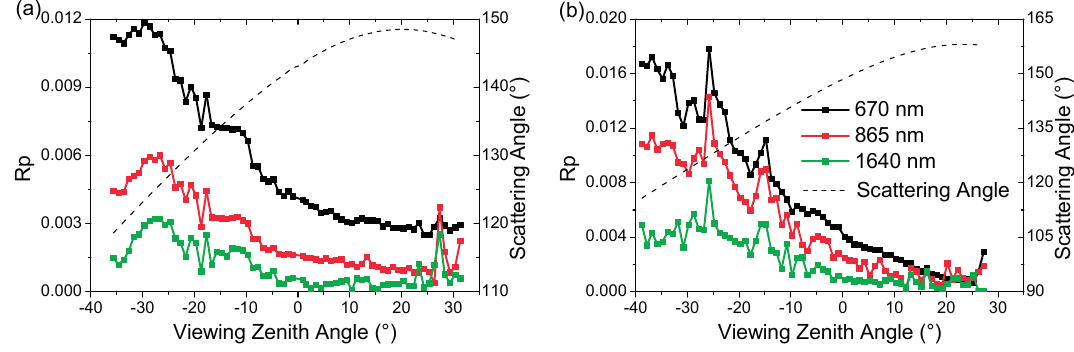
Figure 3. Examples of polarized reflectance measurements of AMPR at 670, 865 and 1640 nm plotted as a function of the viewing zenith angle. ( a ) Case of Flight 2; and ( b ) case of Flight